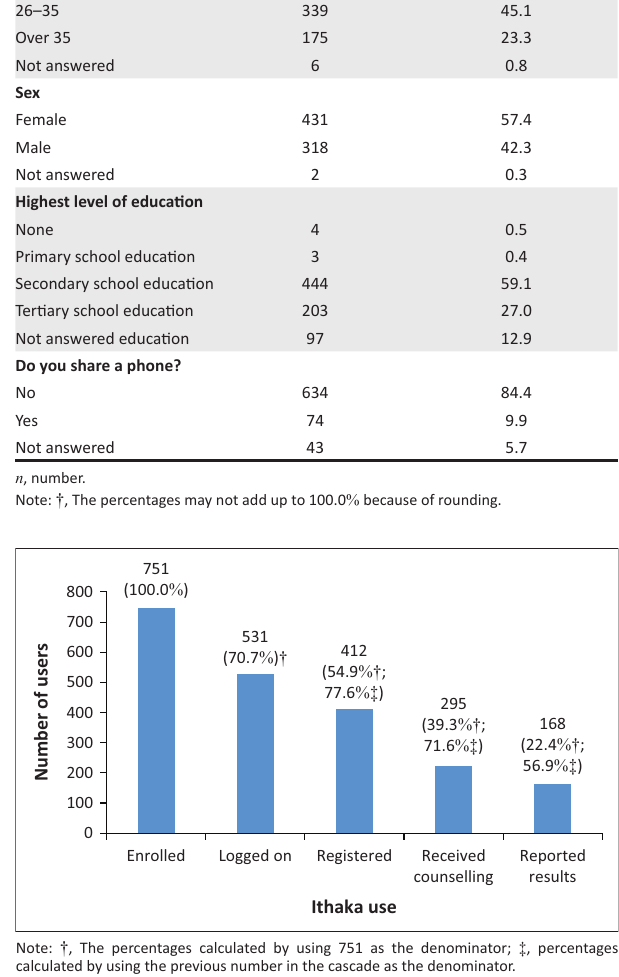
FIGURE 2 : User journey through Ithaka: November 2018 to June